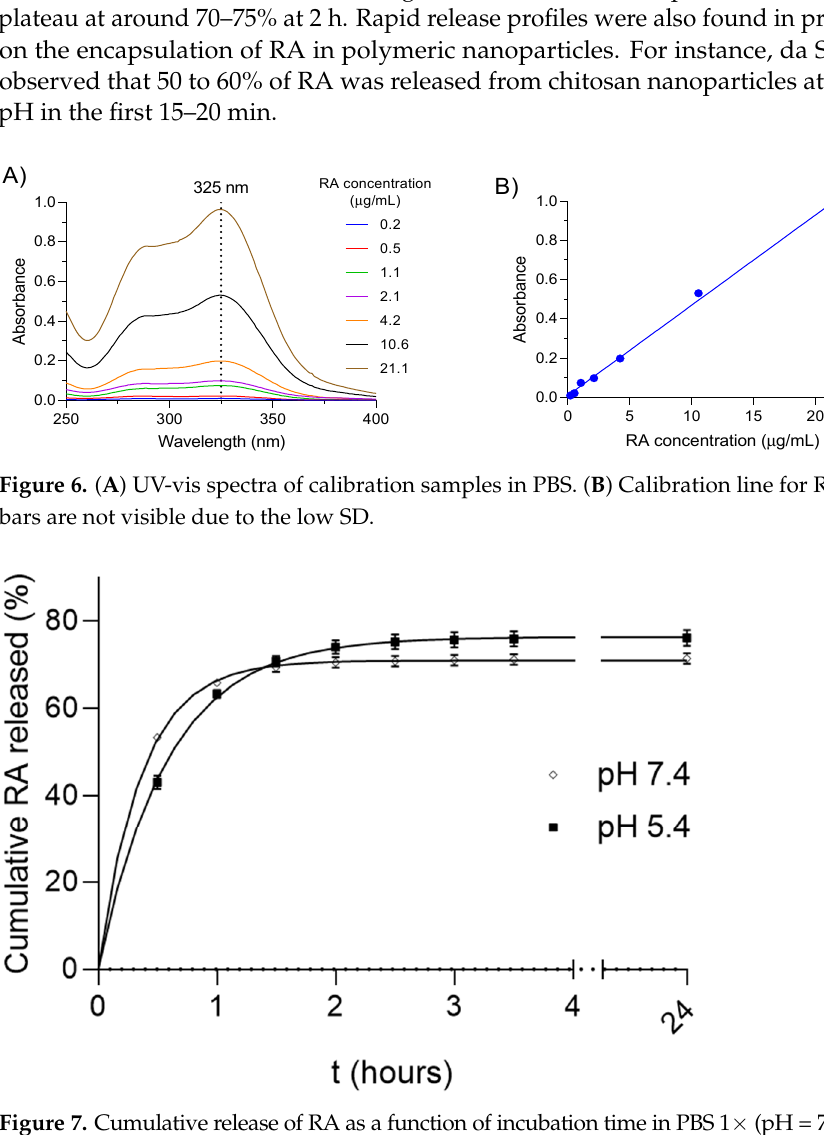
Figure 7. Cumulative release of RA as a function of incubation time in PBS 1 × (pH = 7.4 and pH = 5.4) containing 0.5% of Tween 80 at 37 ◦ C. The symbols represent the average experimental values. Continuous lines represent the best fit with a First order equation.